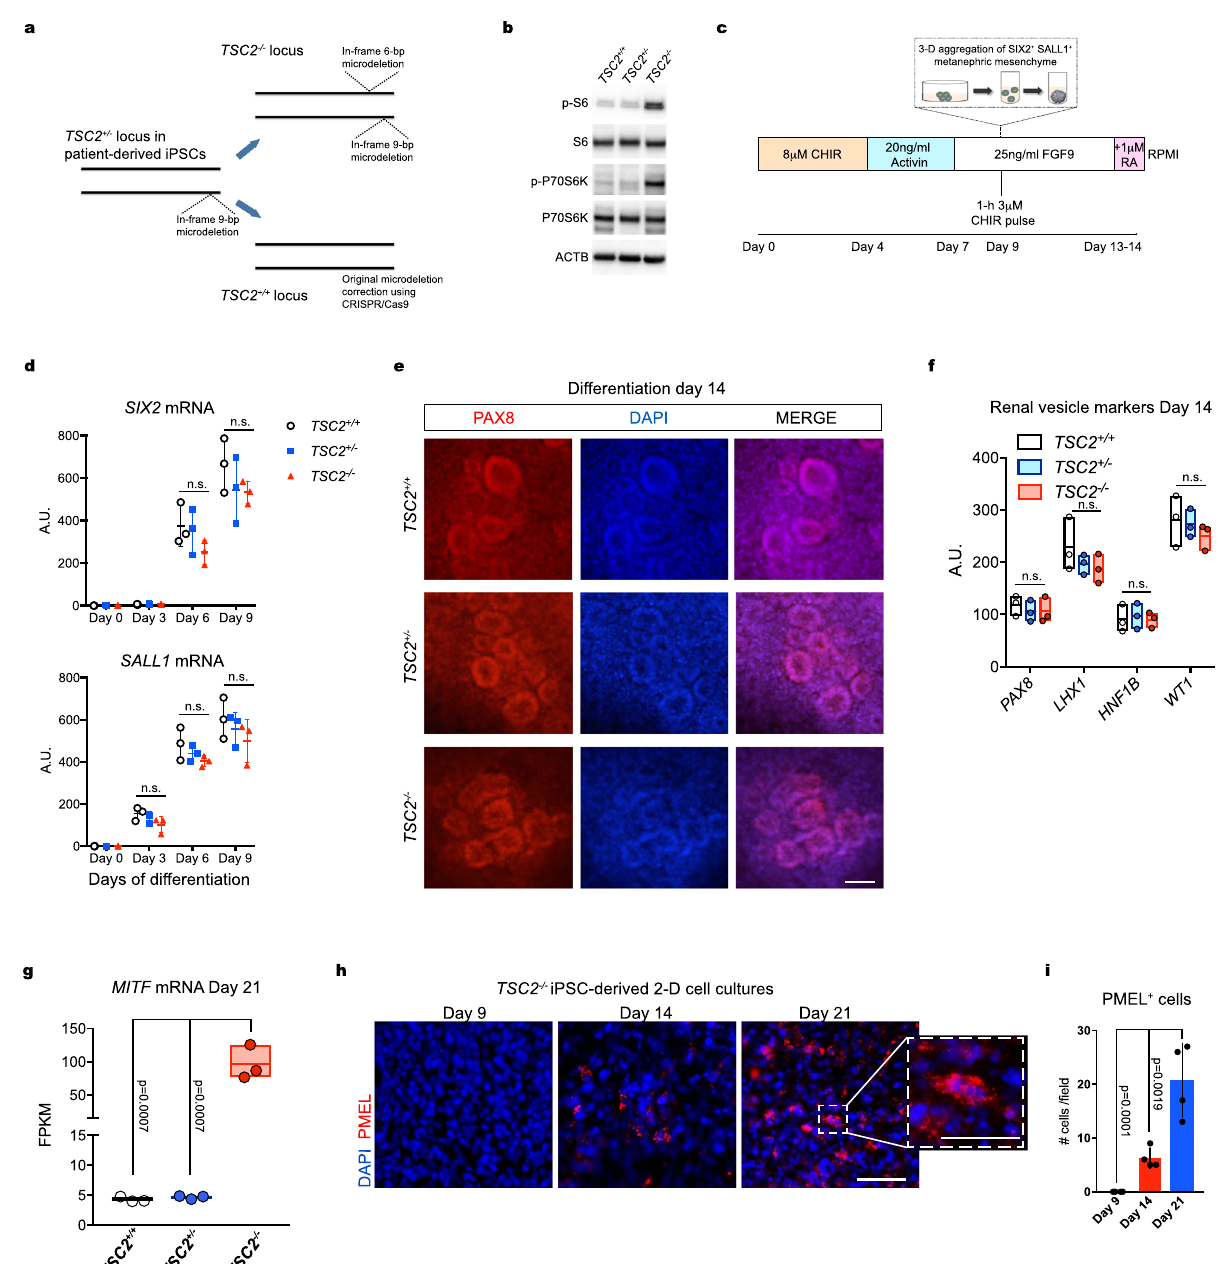
(Fig. 1i). Of note, TSC2 − / − PMEL + cells had a plump myoid morphology of epidermal melanocytes in culture 25,26